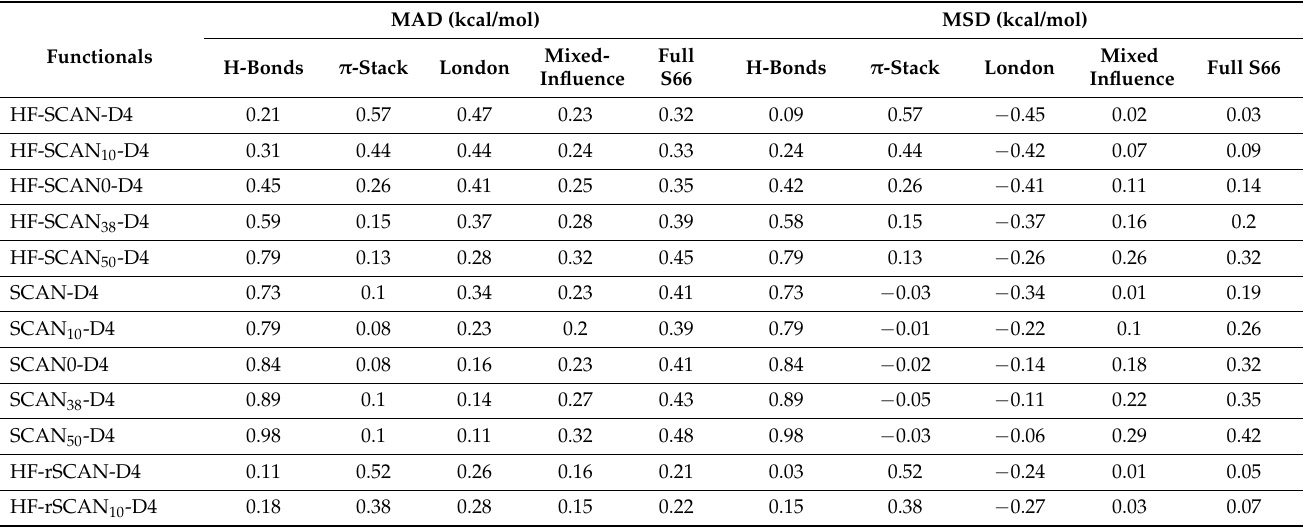
Table 1. MAD and MSD (mean absolute and mean signed deviations, kcal/mol) of HF-DFT-D4 and KS-DFT-D4 functionals for the S66 subset and for four subcategories of